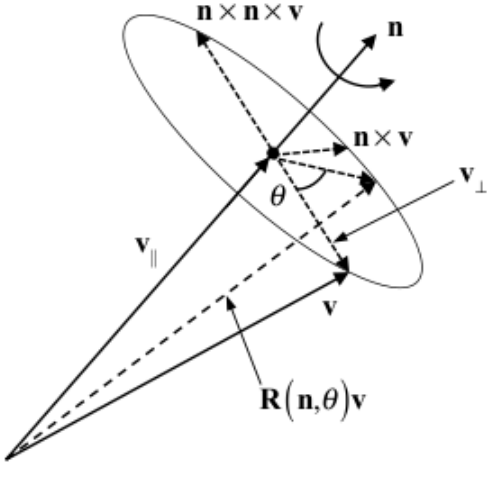
Figure 3. The vector v is rotated about the axis n (Euler axis) through an angle of rotation θ . Note that the rotated vector ( ) , θ R n v shares the parallel component with v